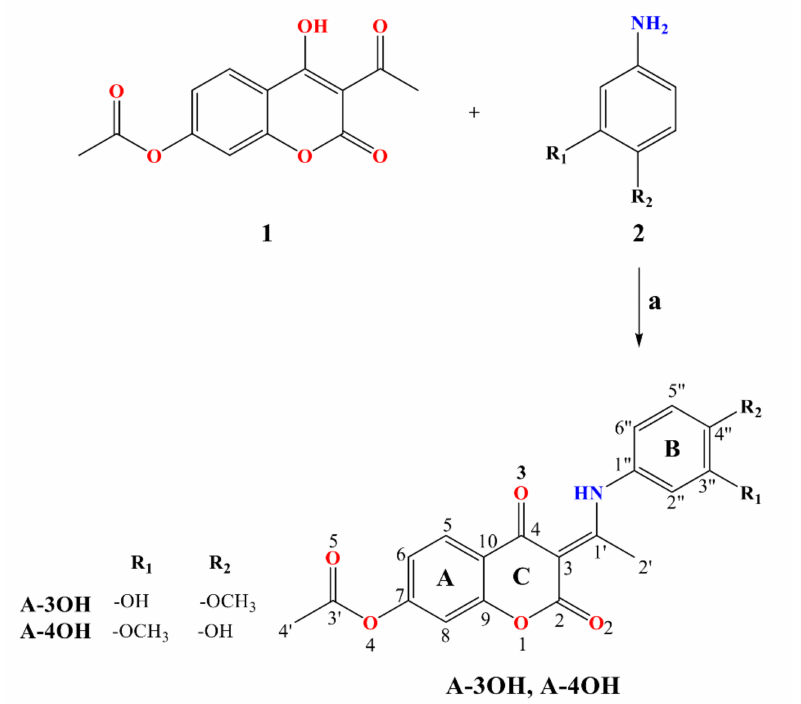
Scheme 1. General procedure for the synthesis of coumarin derivatives with atomic numbering. Reagents and conditions: EtOH, reflux, 3